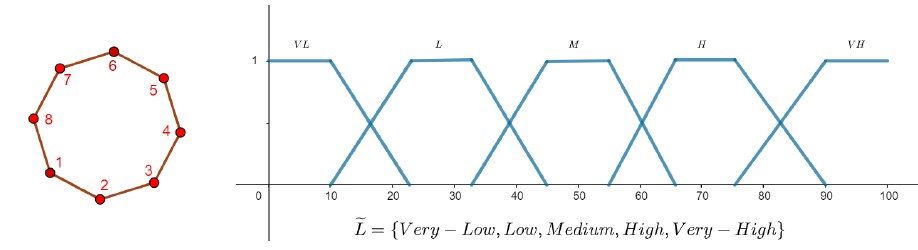
Figure 2. Graph G = ( V , E ) and fuzzy linguistic variable